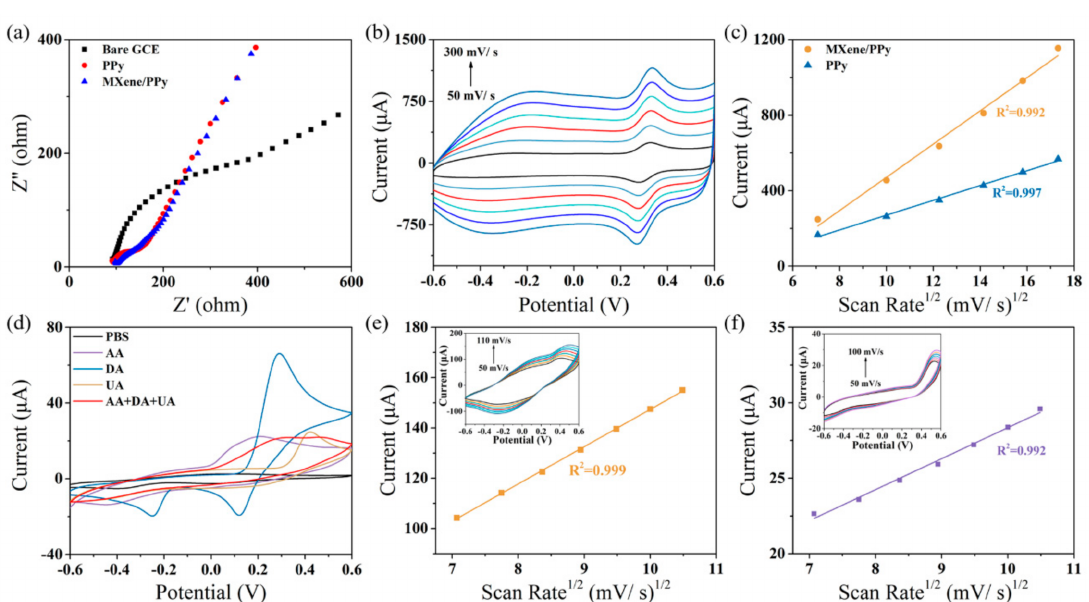
Figure 4. ( a ) Nyquist plots of bare, PPy modified, and MXene/PPy modified electrodes in the presence of 10 mM (Fe(CN) 6 ) 3-/4- containing 0.1 M KCl; ( b ) the CV curves of the MXene/PPy modified electrode with different scan rates (50, 100, 150, 200, 250, and 300 mV/s) in 10 mM K 3 (Fe(CN) 6 ) containing 3 M KCl; ( c ) the calibration curves of current peak vs. the square root of the scan rate for PPy modified and MXene/PPy modified electrodes; ( d ) the CV responses of the MXene/PPy modified electrode for 1 mM AA, 50 µ M DA, and 100 µ M UA in 0.05 M PBS; ( e , f ) the calibration curves of the current peak vs. the square root of the scan rate for the MXene/PPy modified electrode in 0.05 M PBS containing 50 µ M DA and 100 µ M UA, respectively (the insert shows the CV curves of the MXene/PPy modified electrode with different scan rates (50, 60, 70, 80, 90, 100, and 110